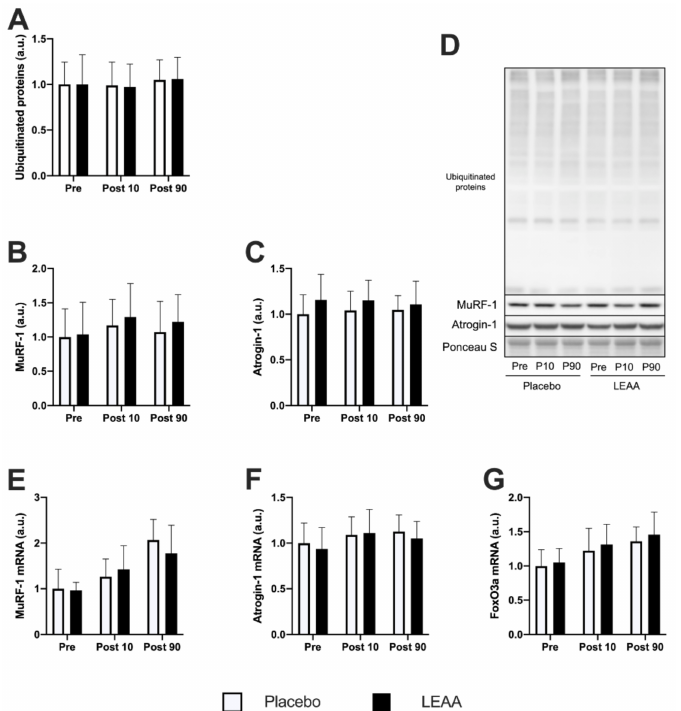
Figure 5. The protein and mRNA expression of factors in the ubiquitin–proteasome system. The expression of ( A ) ubiquitinated proteins, ( B ) MuRF-1, ( C ) Atrogin-1, and ( D ) the representative bands. The mRNA expression of ( E ) MuRF-1, ( F ) Atrogin-1, and ( G ) FoxO3a. The data were analyzed using ANCOVA adjusted for baseline values. The data are expressed relative to the pretreatment conditions in the placebo group as the mean ± SD. No significant di ff erence was observed between the groups at each time point.